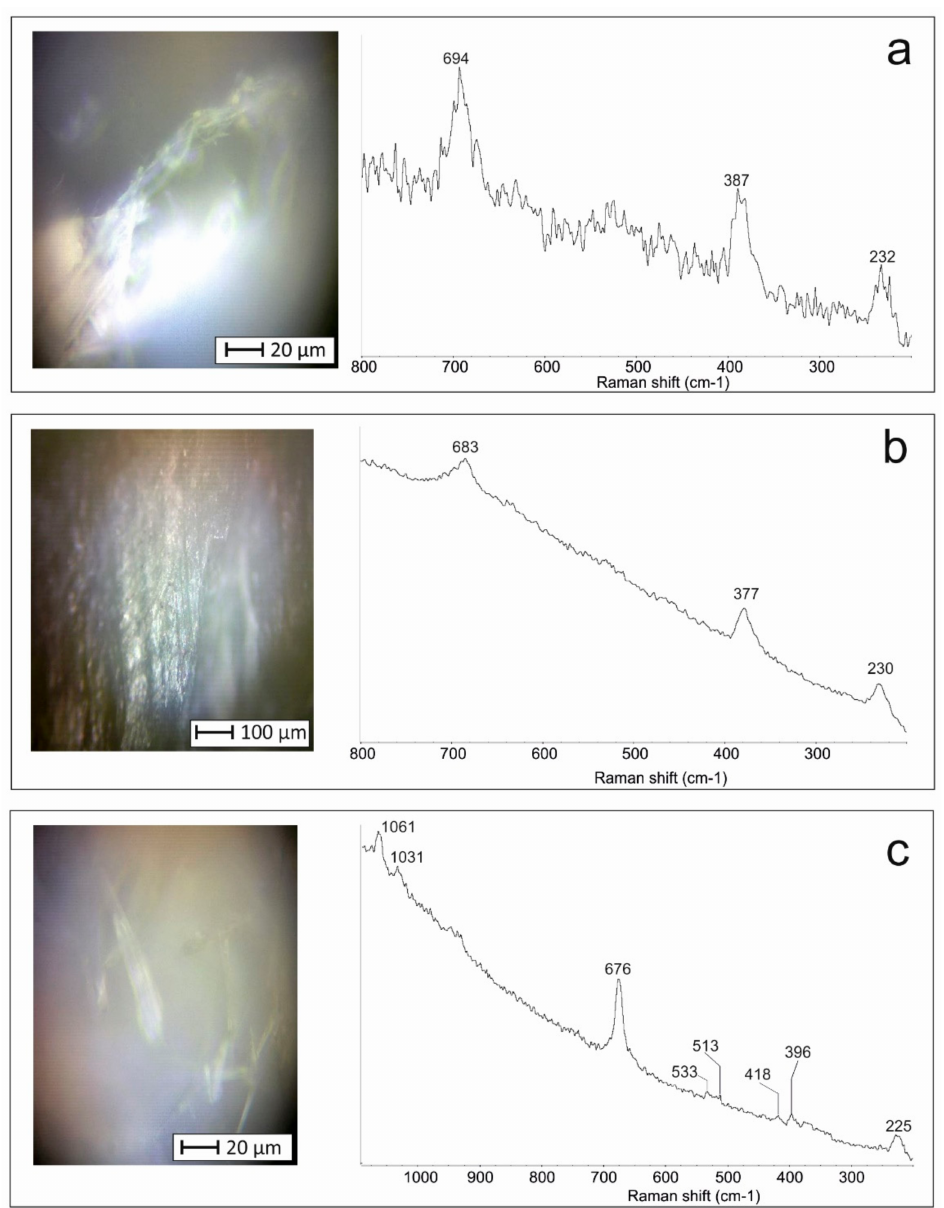
Figure 5. ( a ) p- µ R spectrum identifying chrysotile fibers, ( b ) p- µ R spectrum identifying lamellar antigorite, ( c ) p- µ R spectrum identifying fibrous